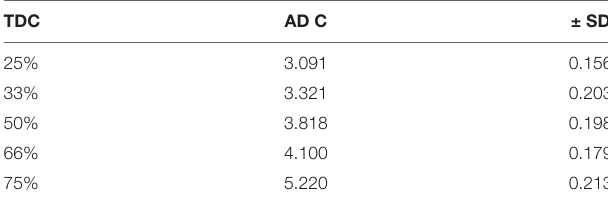
TABLE 1 | ADC in the microspheres prepared by normal